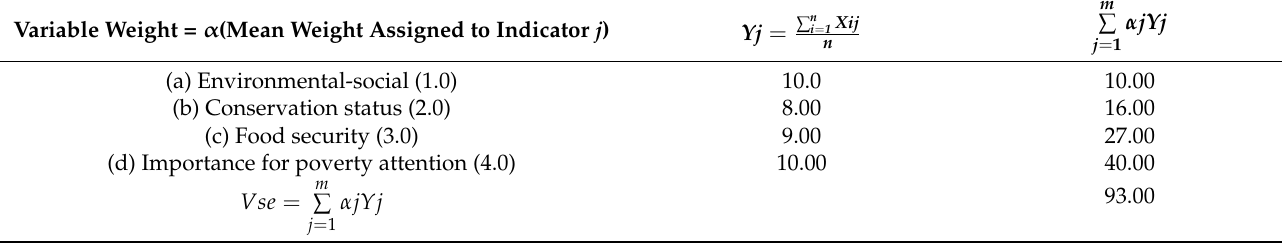
Table 3. Multicriteria analysis of binary